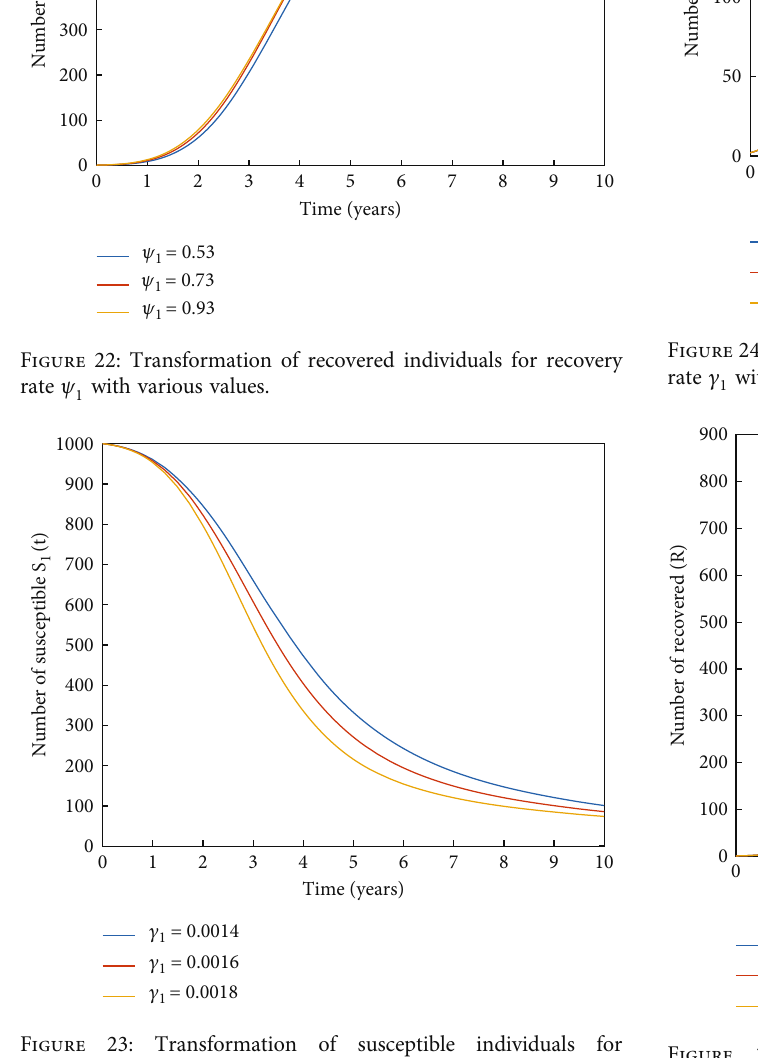
Figure 25: Transformation of recovered individuals for transmission rate γ 1 with various